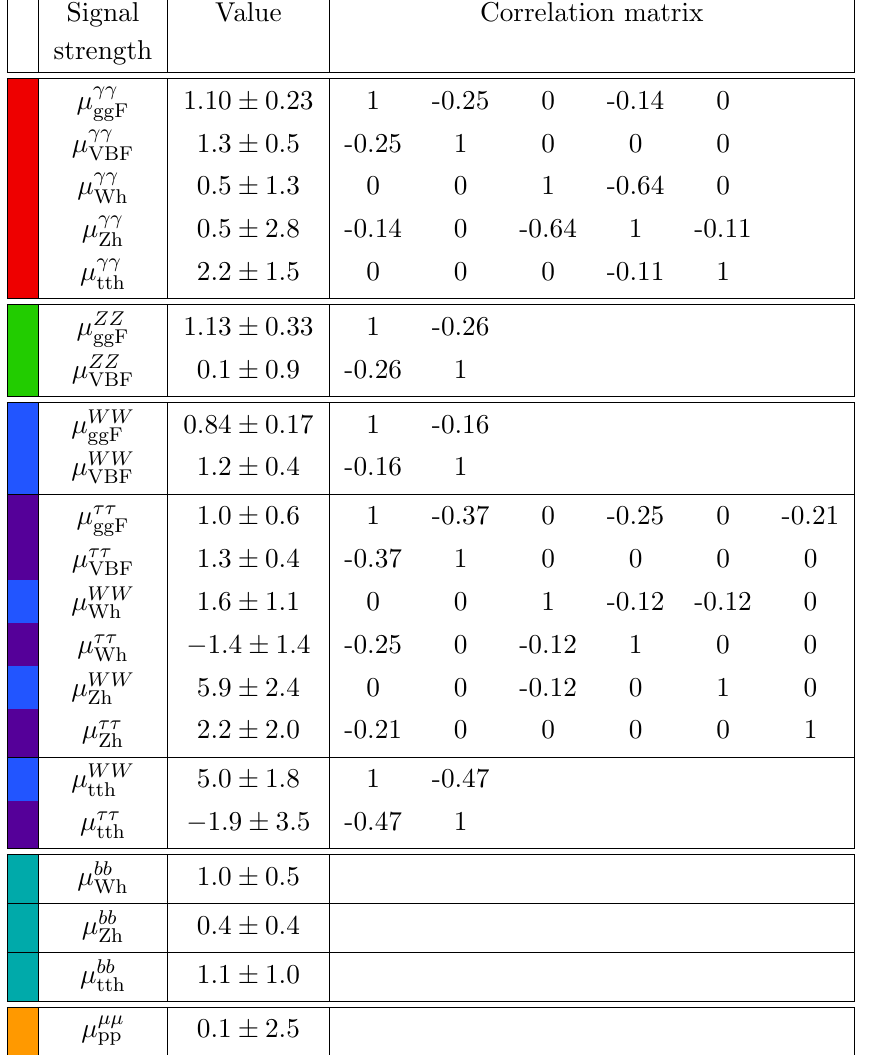
Extreme tan (cid:12) values outside the chosen prior are expected to be excluded due to the absence of strong 2HDM e(cid:11)ects in certain (cid:13)avour observables (see e.g. reference [36]);